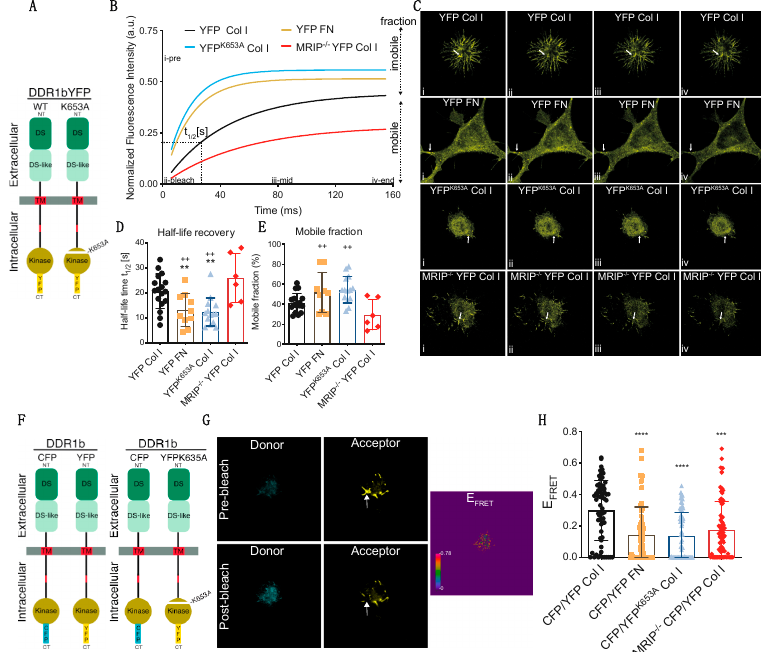
rates and smaller mobile fractions. These cells form smaller clusters compared to DDR1bYFP and MRIP expressing cells cultured on collagen. Notably, the newly-formed clusters become disconnected from the cell bodies, which lead to even slower recovery rates (Figure 6D,E).